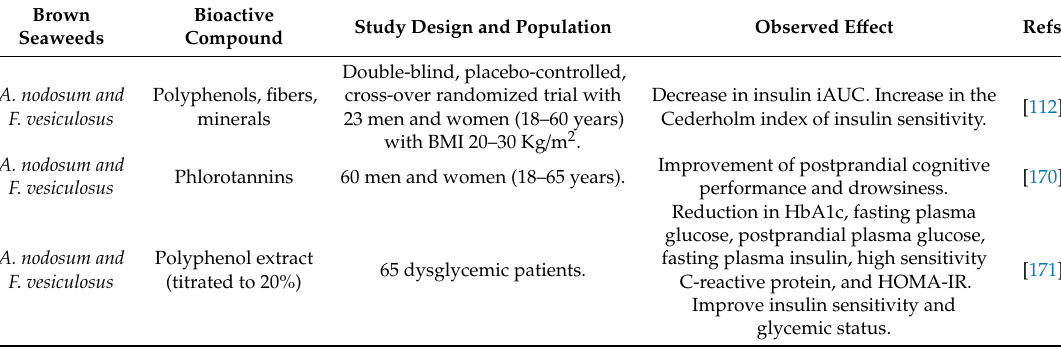
Table 4. Principal clinical studies investigating the e ff ect of brown seaweeds in MS